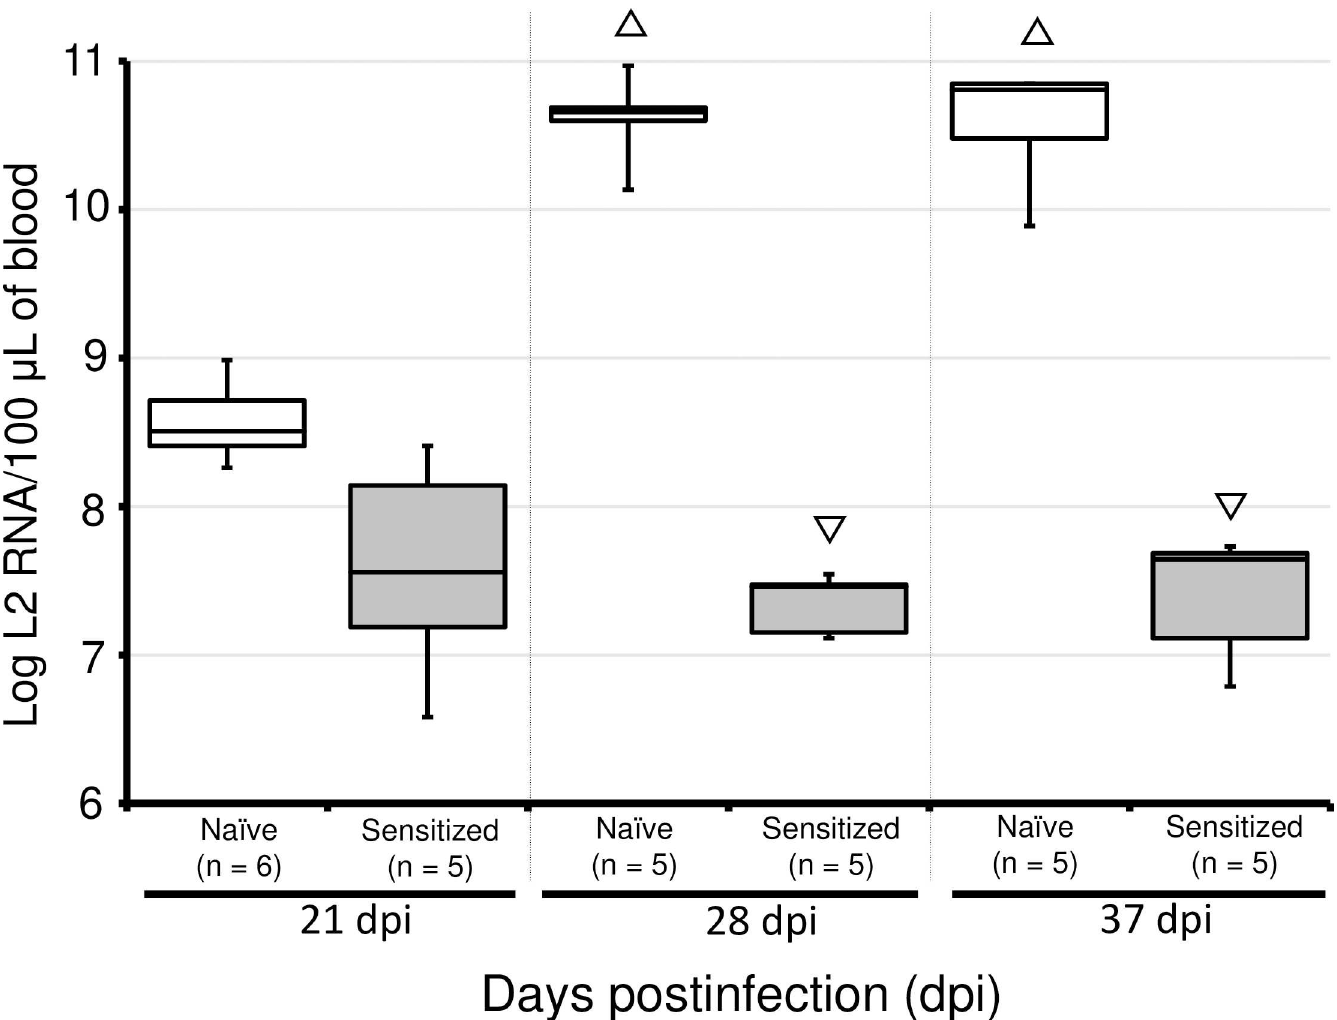
Fig 3. Comparison of time-course changes in the viral RNA loads in EIBS-sensitized and EIBS-na ï ve coho salmon after artificial infection. Nonparametric analysis of multiple comparisons with Steel’s test was used to determine statistical significance ( p < 0.05). Viral RNA loads are given as the copy number of L2 RNA per 100 μ L of peripheral blood. The copy number of L2 RNA was normalized to the copy number of the external standard RNA ( λ polyA + RNA). Upward triangle ( 4 ) indicates a significant increase in the viral RNA load, and downwardtriangle ( 5 ) indicatesa significant reduction in the viral RNA load comparedwith the viral RNA load in the na ï ve fish at 21 dpi. Box plots show median, 25th, and 75th percentiles, and whiskers represent minimum and maximum